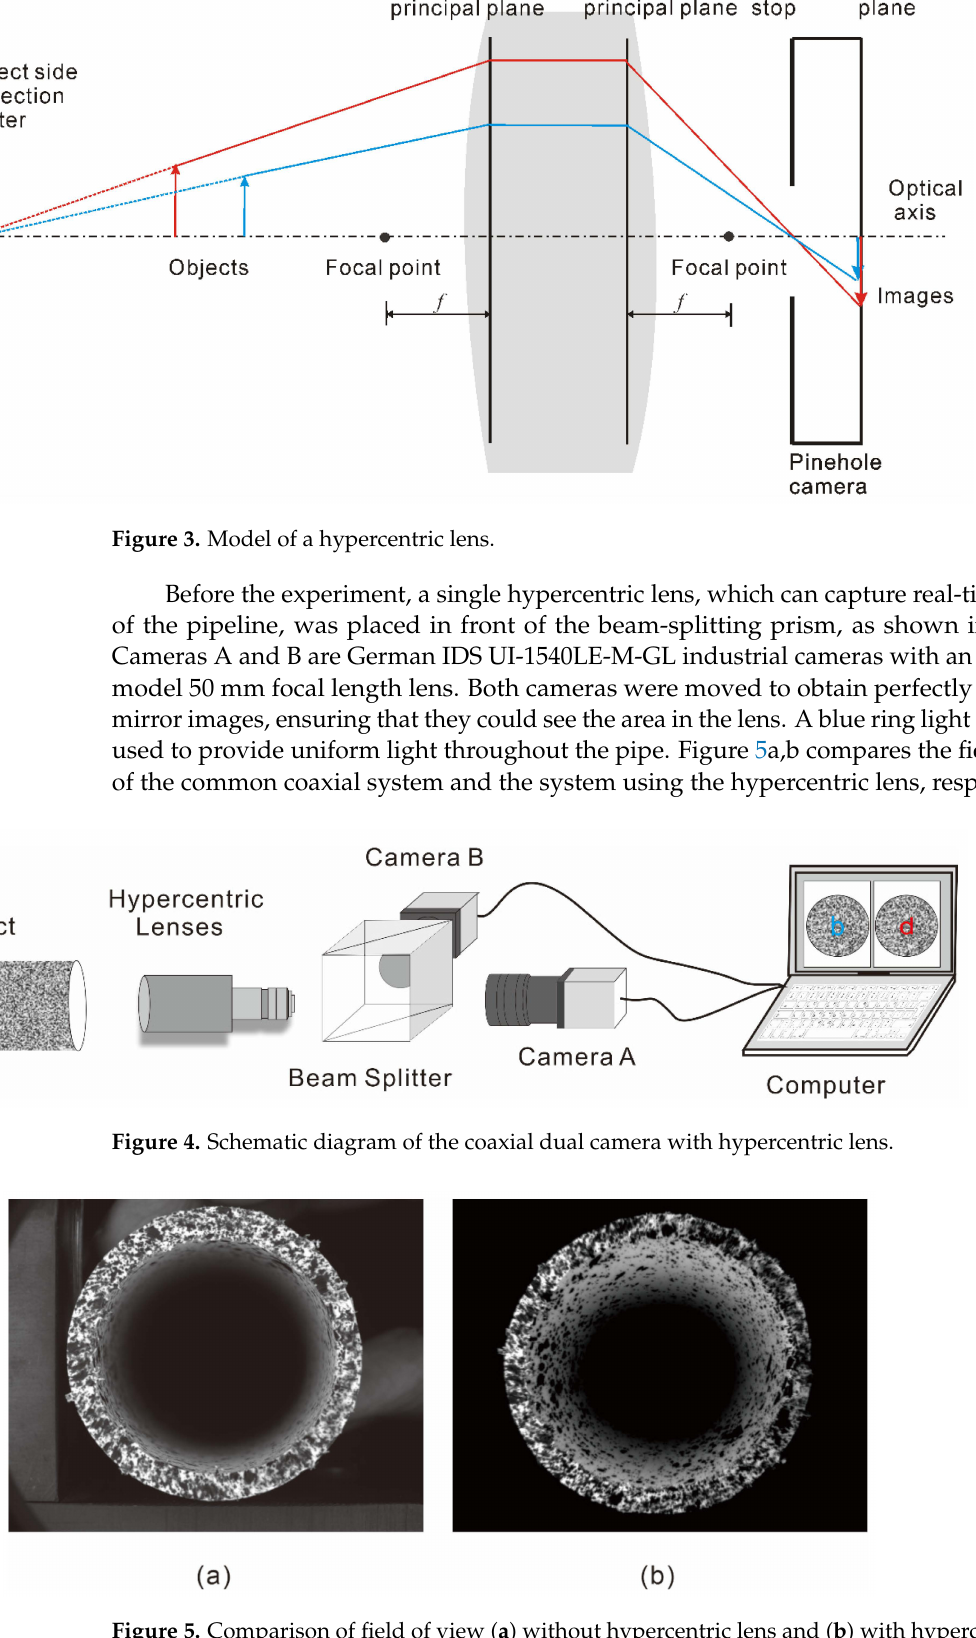
Figure 5. Comparison of field of view ( a ) without hypercentric lens and ( b ) with hypercentric